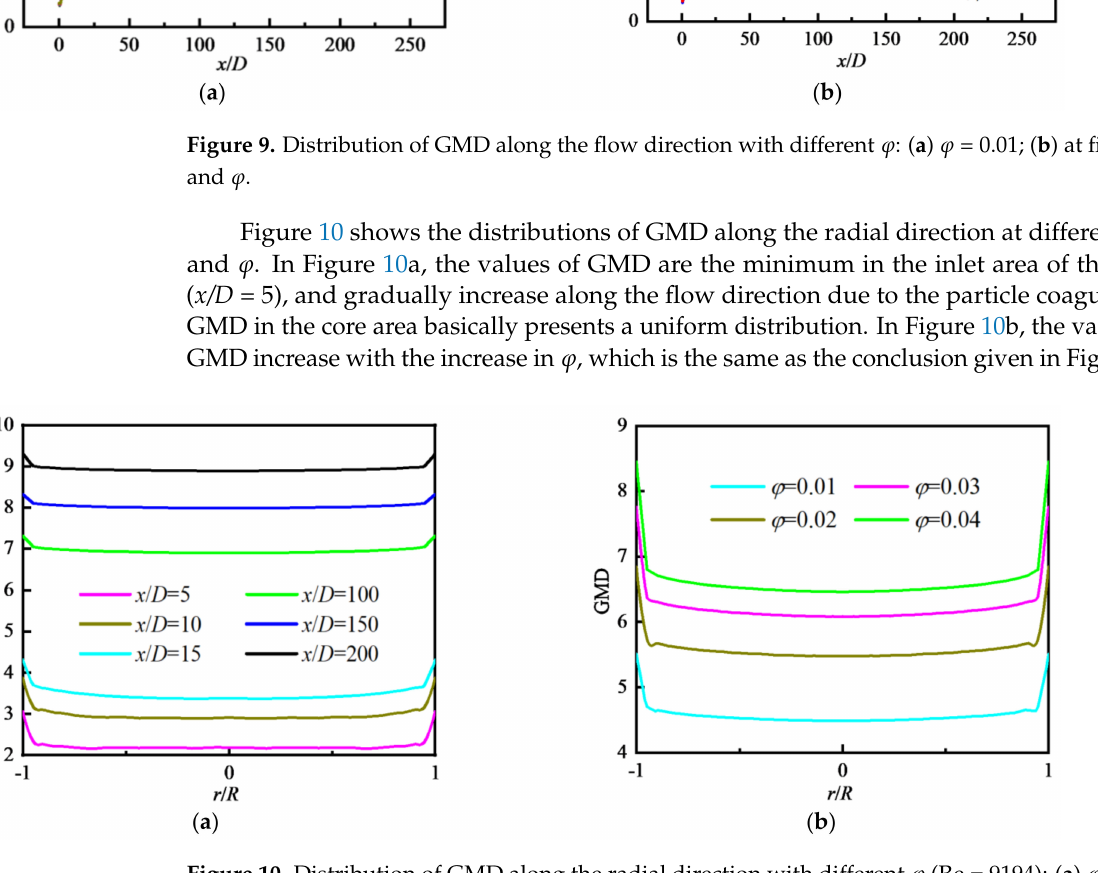
Figure 10. Distribution of GMD along the radial direction with different ϕ (Re = 9194): ( a ) ϕ = 0.04; ( b ) x/D =